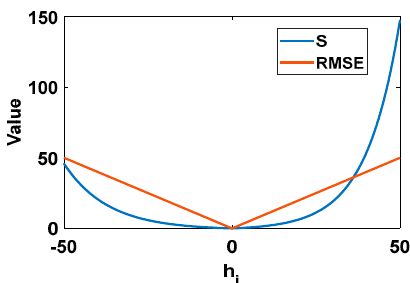
Figure 6. Comparison between the score of the first evaluation function (S) and root mean square error (RMSE) when the number of aircraft engines (N) is set to 1. Table 5. The performance of the model (std: standard deviation).